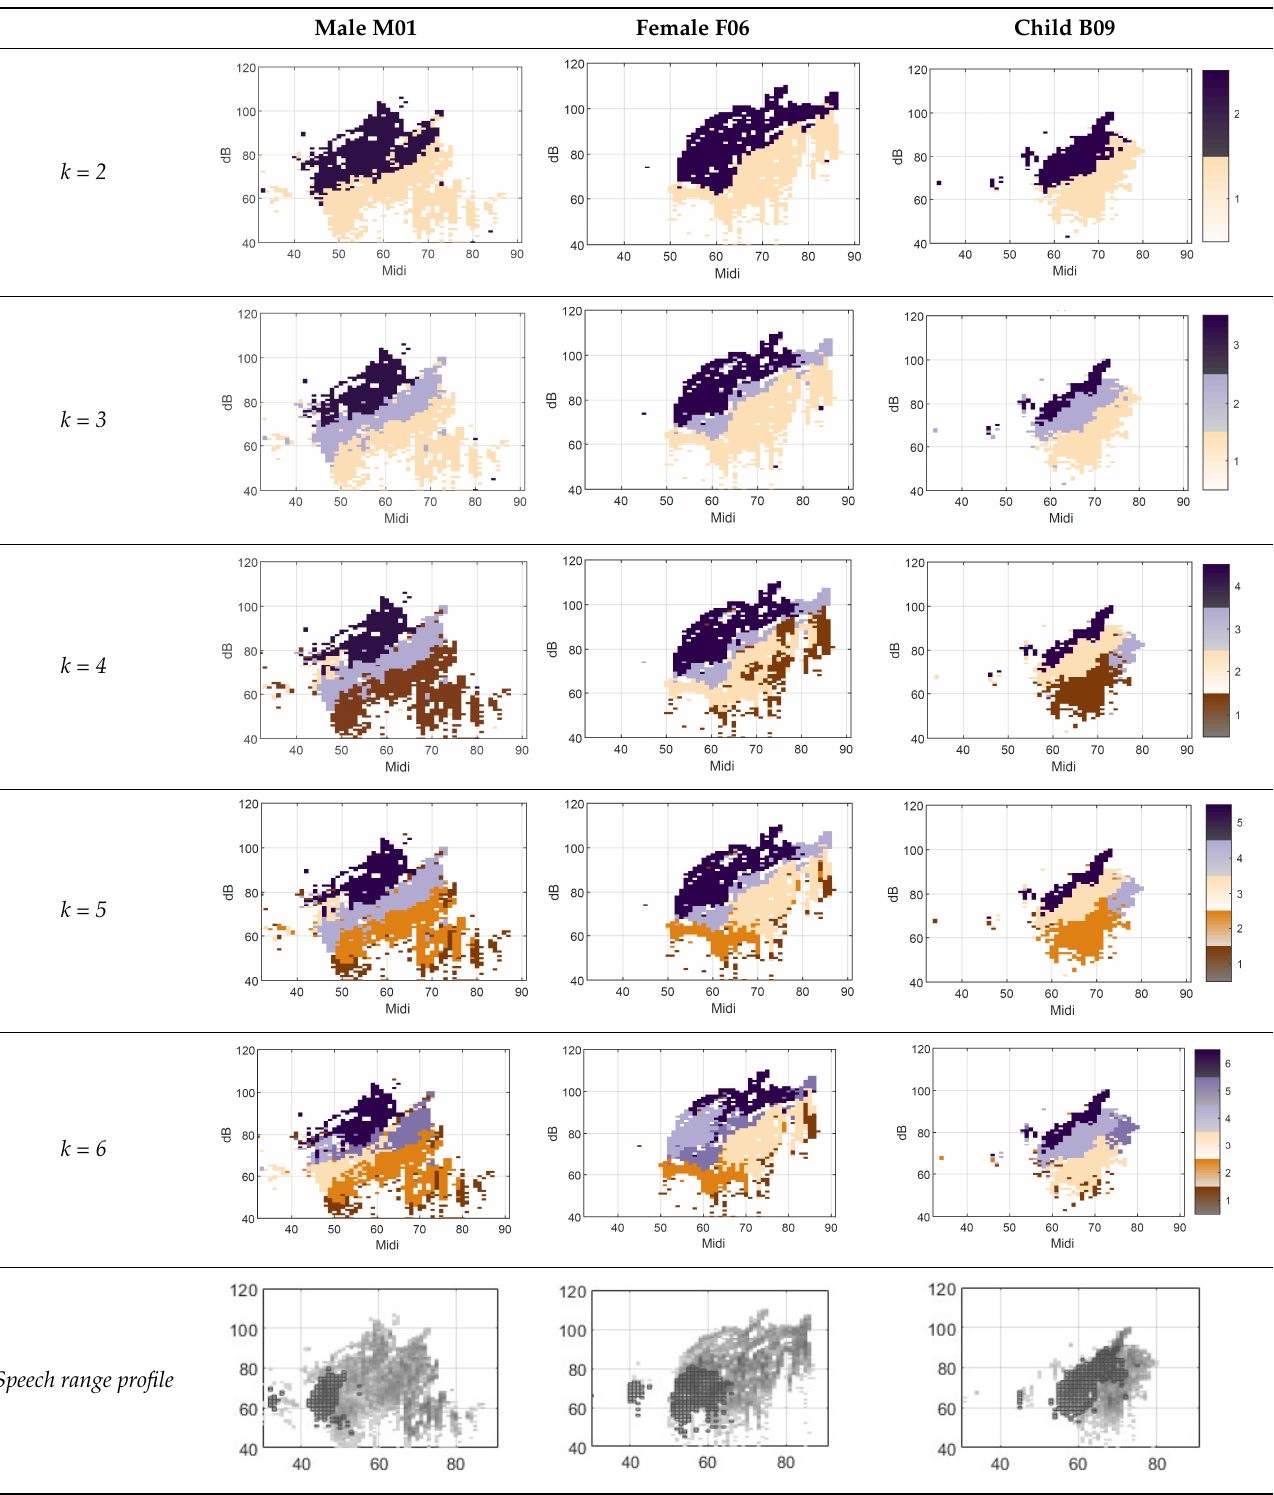
Table 2. Male participant M01, female participant F06, and child participant B09, with their voice maps by cluster numbers. Notice that the colors across k indicate only the relative position. The same color not necessarily denotes the same cluster. The last row represents the speech range profiles, marked as grids, overlapping on the density map, where the darker the region, the more VF cycles are contained. This enables a comparison of the whole voice range with the habitual speech range. The x -axis is f o in semitones (on the MIDI scale, 48 = 110 Hz), and the y -axis is SPL in dB(C) at 0.3 m.